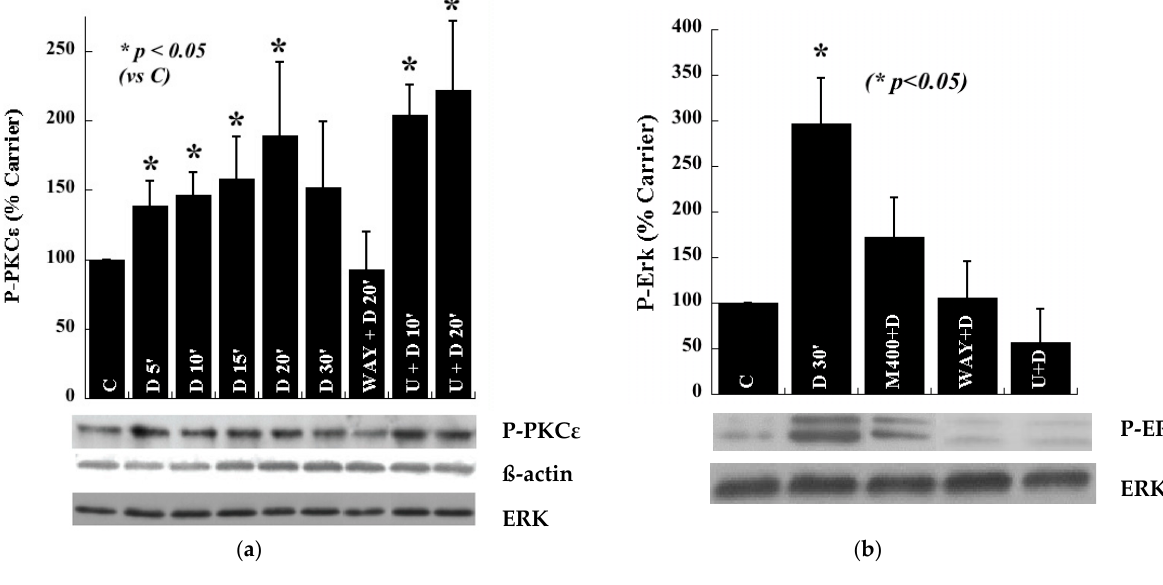
Figure 1. Serotonin 1A receptor-mediated activation of PKC ε and ERK1/2 in proliferating hippocampal neuron-derived HN2-5 cells. ( a ) Relative to carrier (C) (vehicle) treatment, agonist (8-OH-DPAT, D) (100 nM) caused maximal activation of PKC ε in 20 min (measured using a P-Ser 729 -PKC ε antibody and normalized to ERK), which was eliminated in the presence of the 5-HT 1A -R antagonist WAY100635 (WAY) (10 µM), but not in the presence of the MEK inhibitor U0126 (U) (10 µM). ( b ) Relative to carrier treatment (C), 8-OH-DPAT (D) treatment (100 nM) caused a dramatic increase in the activity of ERK1/2 in 30 min (measured using a P-T 202 , Y 204 -ERK antibody, normalized to ERK), and this activation was blocked in the presence of the PKC ε inhibitor (M) (400 nM) and also U0126 (10 µM). In ( b ) * p < 0.05, D versus carrier and each of the inhibitors ( t -test). Data were analyzed from distinct Western blots obtained from three different cultures of HN2-5 cells. (See Figure S1 in Supplementary Material for the effect of inhibitors alone).